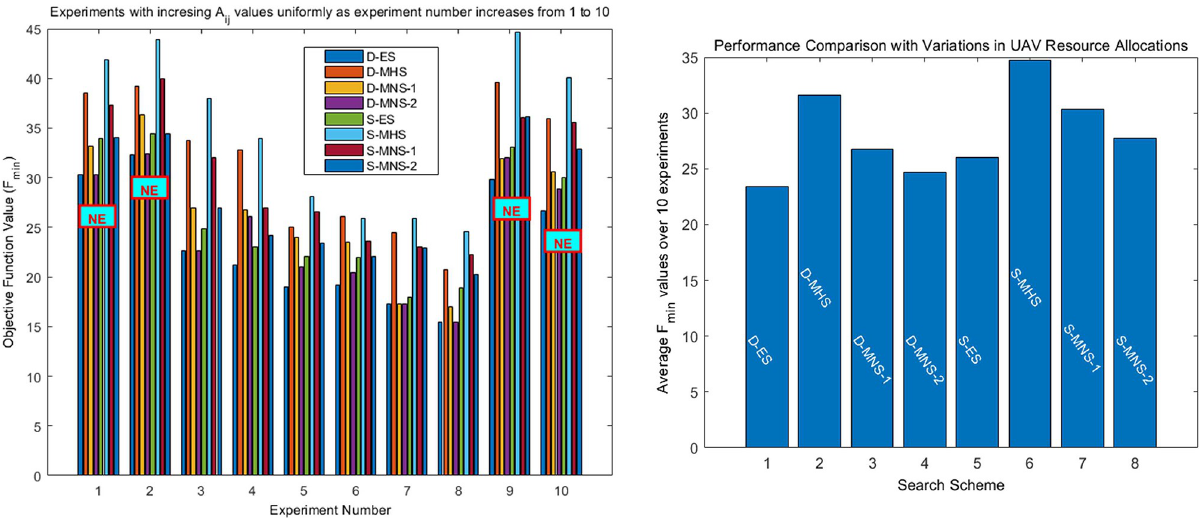
Fig 6. (a) F and success/failure results with A resource values decreasing systematically as experiment number increases from 1 to 10. (b) min i , j Performance comparison in terms of average F values for experiments involving variations in allocated resource values. A l min https://doi.org/10.1371/journal.pone.0283923.g006 again the effectiveness of MNS-2 schemes. The schemes illustrated in Fig 6(a) select a subset of operators (UAVs) for each experiment. In order to elaborate UAV selection in the experi-